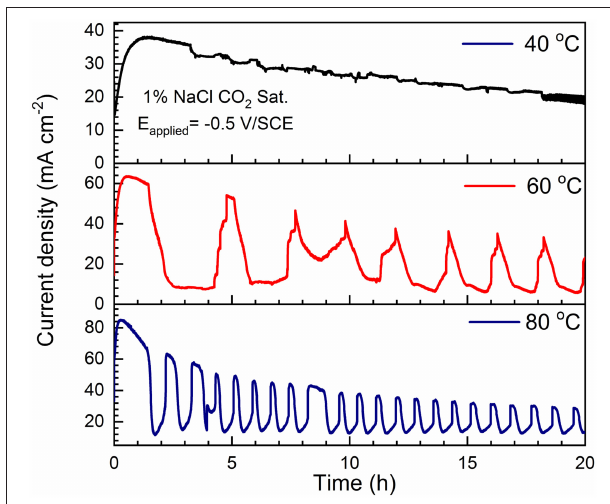
FIGURE 11 | Potentiostatic polarization curves (E applied = − 0.5 V/SCE) of C1010 steel tested in 1% NaCl with CO 2 saturation for 20h at different temperature levels, i.e., 40, 60, and 80 ◦